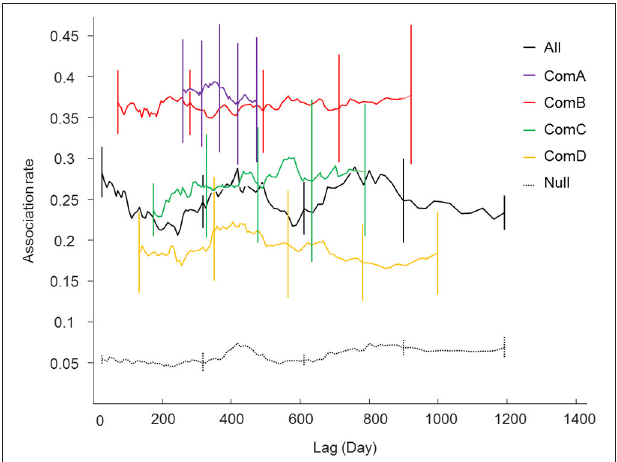
FIGURE 3 | Lagged association rates (LAR) for all individuals (black line) and within the communities (ComA purple; ComB red; ComC green; and ComD yellow). The null association rate (dash lines) and jack-knife error bars are shown.